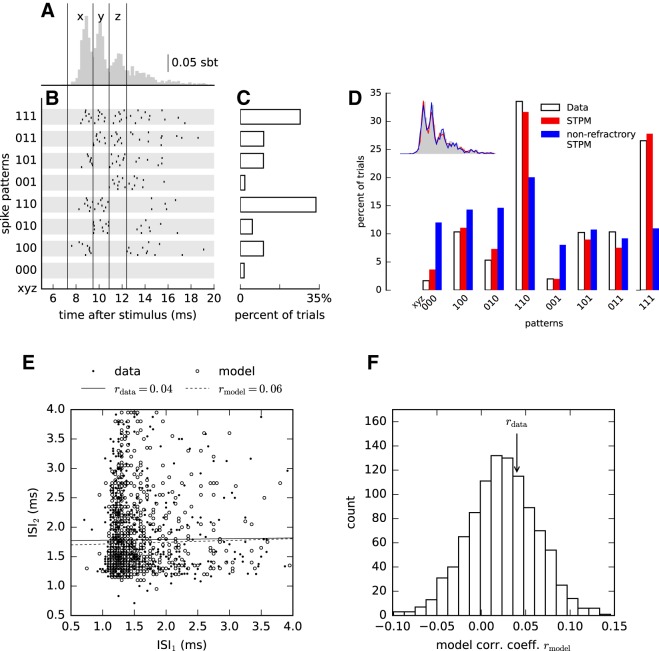
The STPM explains trial-to-trial variability of the data. A, Single-neuron responses averaged over all trials (PSTH, same as in Fig. 1B) reveal that spikes occur preferentially at discrete latencies (delimited by vertical lines and indexed by x for the first peak, y for the second peak, and z for the third peak). B, In single trials, multiple spikes are elicited in diverse combinations of preferred latencies resulting in significant trial-to-trial response variability. Spike combinations are classified into spike patterns. The time axis was first divided into three windows aligned to the peaks of the PSTH. Each trial was then assigned a binary string (spike pattern xyz, from 000 to 111), where 1 represents the occurrence and 0 the absence of a spike in a window. Spike timings of eight representative sample responses assigned to each pattern are shown as raster plots. C, Frequency at which the spike patterns occurred over repeated trials for the neuron in A. D, Firing pattern distribution obtained from the data (white bars, same as C), the STPM (red bars) and the nonrefractory STPM (blue bars). The firing rate of the Poisson model was estimated by a PSTH with bin size 0.05 ms. Inset compares the PSTHs obtained from each model (color-coded like the bars in main panel). E, Scatter plot of two consecutive ISIs within spike triplets calculated from the experimental data (filled circles) and responses simulated with STPM (empty circles). Serial correlations (Pearson’s correlation coefficient) found in the experimental intervals (rdata) differ only slightly from the respective correlations predicted by the STPM (rmodel, see values in the legend, solid and dashed lines represent the best linear fit to the experimental and model data, respectively). F, Repeated Monte-Carlo simulations (n = 1000) of the STPM fitted to experimental data provide the distribution of serial correlations consistent with the STPM (empty bars); the serial correlations estimated directly from experimental data (vertical arrow, rdata) are likely to be drawn from the same distribution (two-sided bootstrap test, p = 0.81).